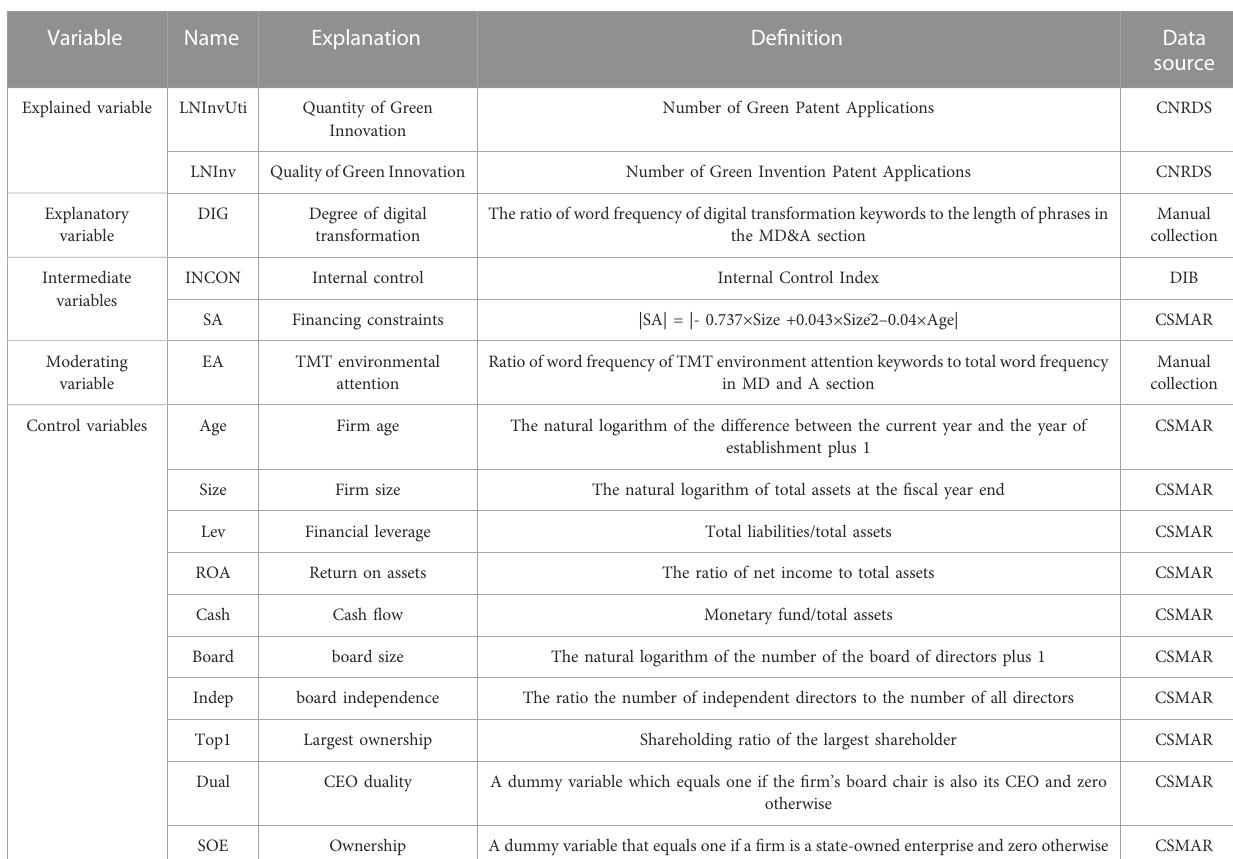
TABLE 1 Variable de fi